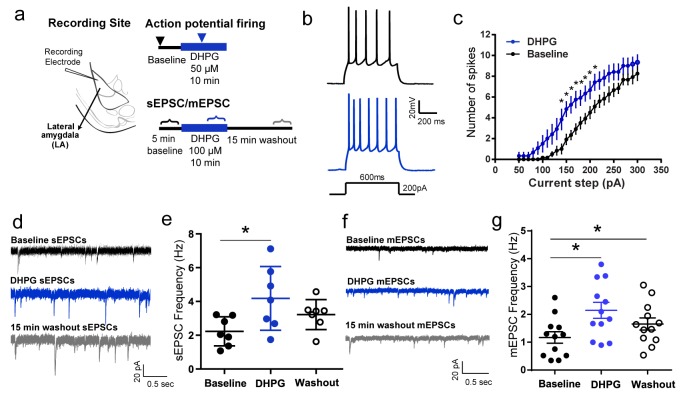
Pharmacological activation of mGluR5 using DHPG enhances intrinsic and synaptic excitability in LA principal neurons in vitro.(a) Placement of recording electrode in a coronal brain slice of the lateral amygdala (LA) (left). Schematic of experimental protocols (right). Current-clamp recordings of action potential firing (right, top) was compared using a range of current injections (600 ms, 50–300 pA, 10 pA steps) between baseline firing before DHPG application (▾) and during a 10 min bath application of 50 µM DHPG ( ). Voltage-clamp recordings of spontaneous EPSCs and miniature EPSCs were made (right, bottom) before ( ), during ( ) and 15 min after ( ) bath application of 100 µM DHPG for 5 min each in the same neuron. (b) Representative traces of accommodating action potential firing from a LA principal neuron in response to depolarizing current injections (200 pA) before (top, black) and after DHPG application (bottom, blue). (c) Averaged number of spikes fired shows an increase in excitability after DHPG application across a range of current injections (n = 6 neurons, p<0.05). (d) Representative traces showing voltage clamp recordings (VHOLD = −70 mV) of sEPSCs from LA neurons before (black), during (blue) and 15 min after washout of DHPG (grey). (e) DHPG causes a significant increase in the mean frequency of sEPSCs that returns to baseline levels after washout (n = 7 neurons, p<0.05). (f) Representative traces showing voltage clamp recordings (VHOLD = −70mV) of mEPSCs from LA neurons before (black), during (blue) and 15 min after washout of DHPG (grey). (g) DHPG causes a significant increase in the mean frequency of mEPSCs that remains elevated even after 15 min of washout (n = 12 neurons, p<0.05). *p<0.05 in all the graphs.DOI:
http://dx.doi.org/10.7554/eLife.25665.00210.7554/eLife.25665.003Figure 1—source data 1.Data for individual cells representing the number of spikes generated in response to current injection (Figure 1c), frequency of sEPSCs (Figure 1e) and frequency of mEPSCs (Figure 1g) during baseline recordings, in the presence of DHPG and after washout of DHPG.